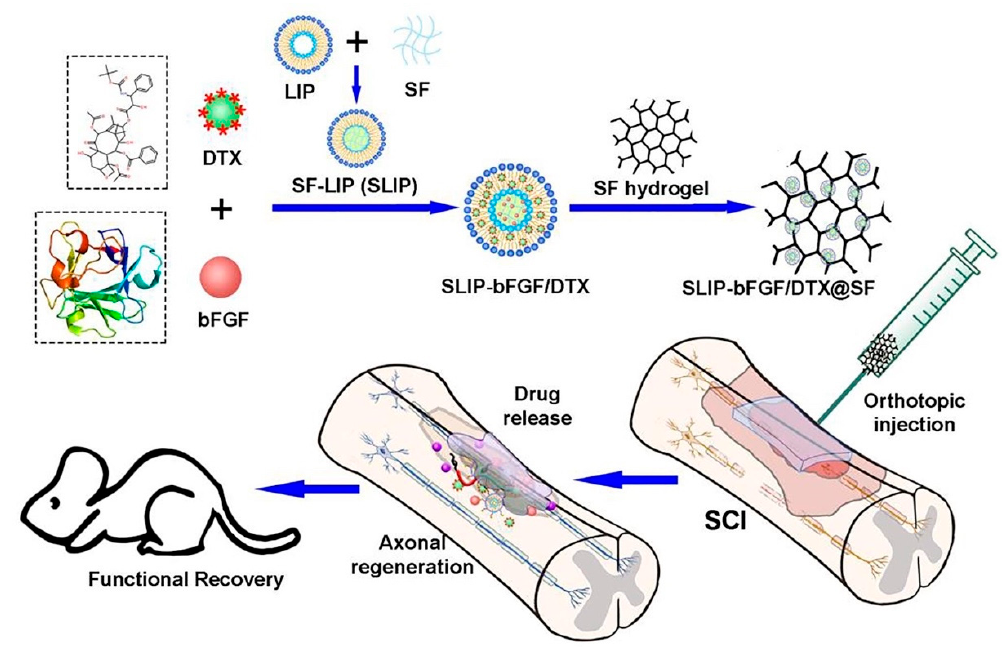
Figure 6. Schematic diagram of the injectable liposome–silk fibroin composite hydrogel as an in situ multiple drug delivery system for the treatment of SCI. Reprinted with permission from [173].